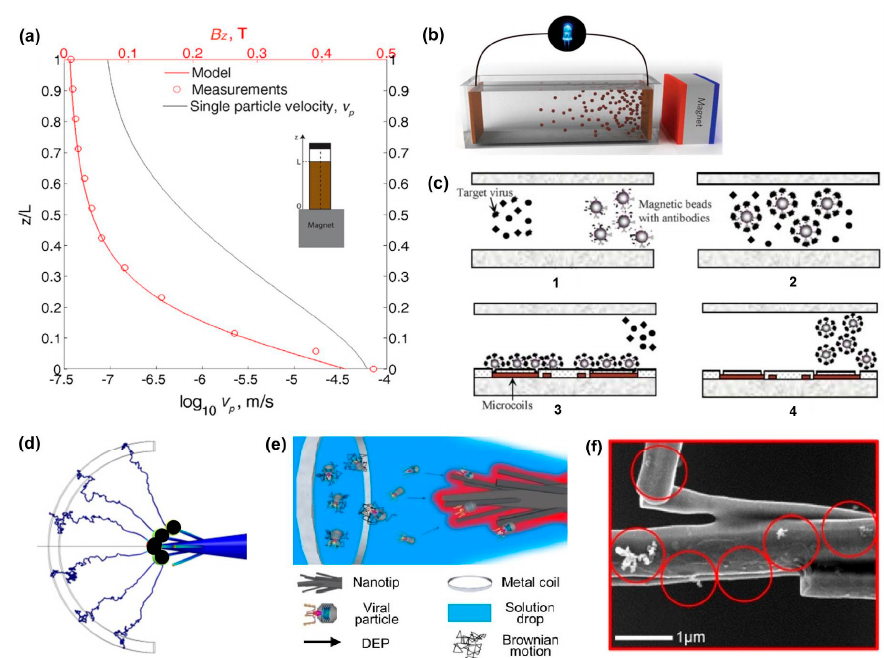
Figure 3. ( a ) graph showing an increase in particle settling velocity with an increase in magnetic field strength (reproduced from Prigiobbe et al. [56]); ( b ) illustration depicting the migration of Fe 3 O 4 nanoparticles in solution under the influence of a magnetic field (reproduced from Yan et al., [57]); ( c ) illustration of a magnetically assisted concentration device for detection of Dengue virus (reproduced from Lien et al. [58]): ( c-1 ) antibody-conjugated magnetic beads are introduced to the viral solution; ( c-2 ) magnetic beads and viral particles bond; ( c-3 ) bead-virus constructs are concentrated via electrically induced magnetic micro coils downstream; ( c-4 ) constructs are released for analysis by shutting off the micro coils; ( d ) computational analysis showing particle trajectories, induced by dielectrophoresis (DEP), toward a dendritic nanotip; ( e ) illustration of a nanotip electrode for DEP concentration of viral particles; ( f ) representative SEM image of the nanotip with captured T7 phage particles (reproduced from Yeo et al. [63]). Table 3. Viral detection methods via magnetic and/or electric field, grouped by detection unit. (1)